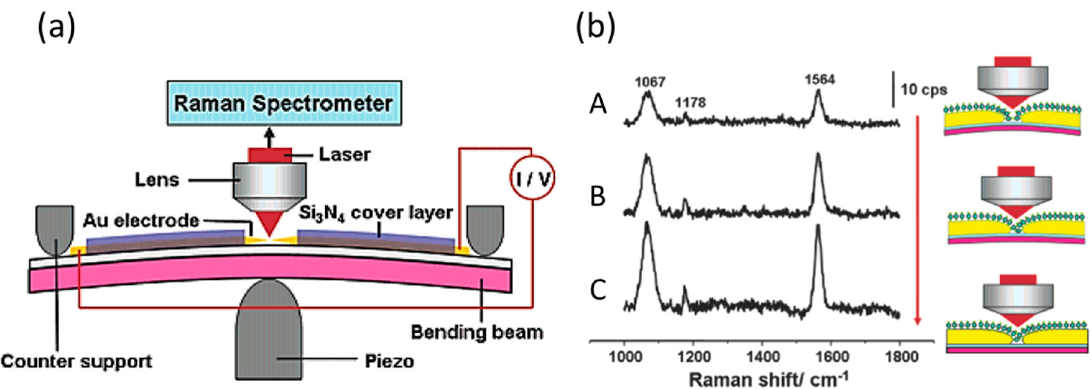
Figure 1. ( a ) The experimental setup for surface-enhanced Raman scattering (SERS) of molecular junctions fabricated with a mechanically controllable break junction (MCBJ); ( b ) SERS of 1,4-benzenedithiol (BDT) molecular junctions with different gap widths. The gap width was (A) 0.8 nm, (B) 0.6 nm, and (C) 0.4 nm. ( λ ex : 632.8 nm) [30].